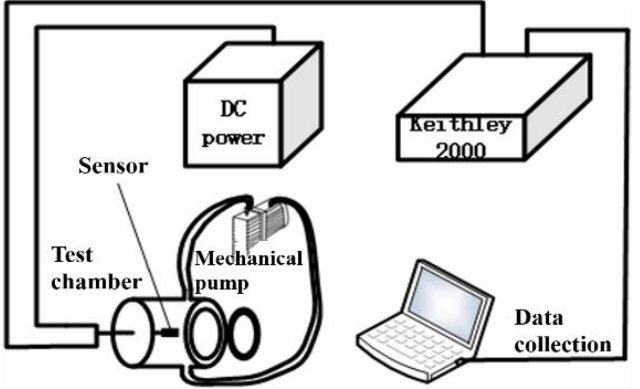
Figure 5. Structure diagram of the gas test system setup.